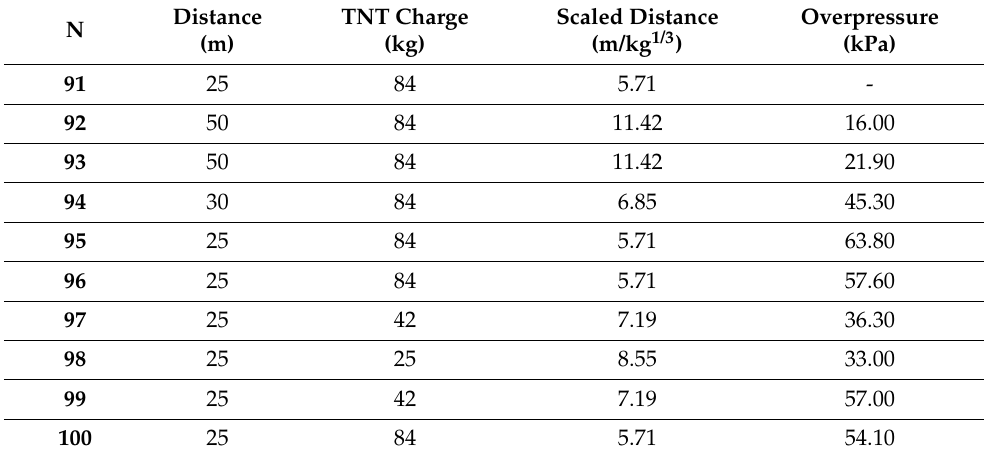
Table 8. Values of scaled distances and air overpressure for each detonated TNT charge.